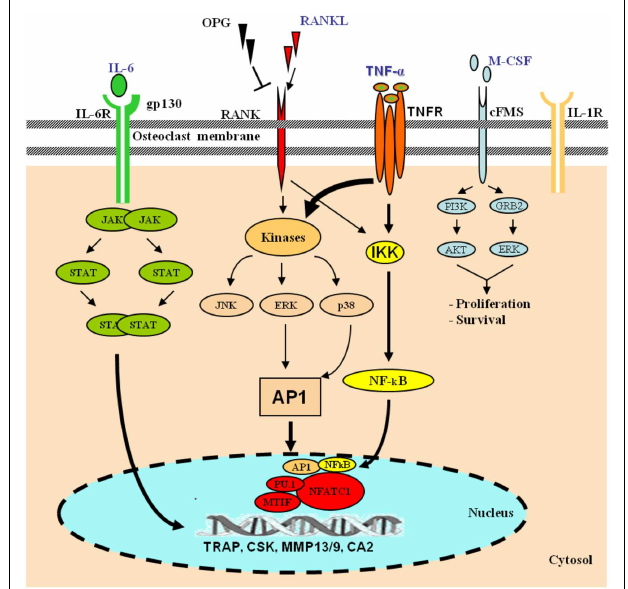
FIGURE 1 | Role ofTNF- α in osteoclast differentiation . Hematopoietic stem cells differentiate along the myelo-monocytic pathway with M-CSF stimulation. Differentiating cells continue along a trajectory toward the osteoclast phenotype under the influence of RANKL, which signals through the transcription factors AP-1 and NF- κ B. In the presence of RANKL, various pro-inflammatory cytokines, includingTNF- α , IL-6, and IL-1, cooperatively orchestrate enhanced osteoclastogenesis.TNF- α signals via NF- κ B and the mitogen-activated protein kinases (MAPKs), and IL-6 via the JAK–STAT pathway.The activation of osteoclasts with the inflammatory mechanisms mentioned leads to exaggerated systemic and local bone loss. [AKT, protein kinase B; CA2, carbonic anhydrase 2; CSK, cathepsin K; ERK, extracellular signal-regulated kinase; IKK, I κ B kinase; JAK, janus kinase; gp130, glycoprotein 130; GRB2, growth factor receptor-bound protein 2; MITF, microphthalmia-associated transcription factor; MMP, matrix metalloproteinase; NFATc1, nuclear factor of activatedT-cells, cytoplasmic 1; PI3K, phosphoinositide 3-kinase; SPI1, spleen focus forming virus (SFFV) proviral integration oncogene spi1; STAT, signal transducer and activator of transcription;TRAP, tartrate-resistant acid